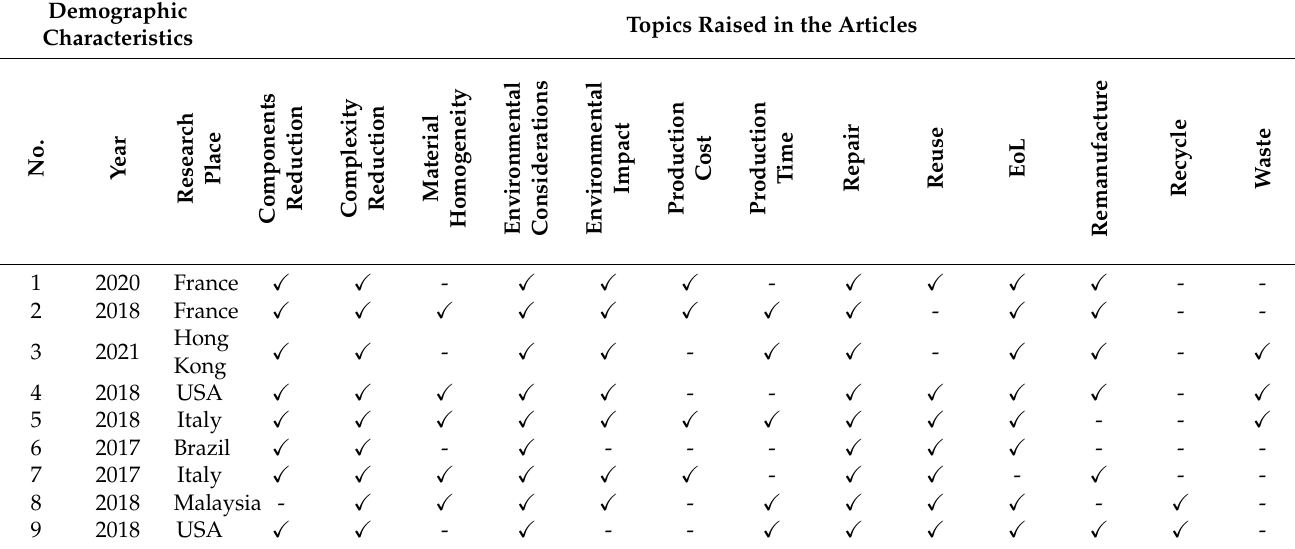
Table 3. The characteristics of the final selected and included articles for review. Demographic Topics Raised in the Articles Characteristics